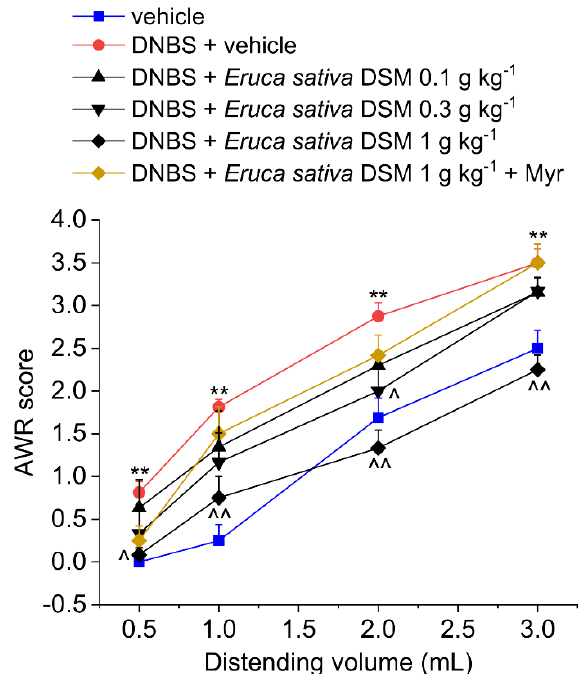
Figure 1. The effect of Eruca sativa DSM acute administration on post-inflammatory visceral pain caused by colitis in rats before and after bio-activation with myrosinase enzyme (Myr). Visceral sensitivity was assessed in animals by measuring the extent of the abdominal withdrawal response (AWR) to colorectal distension, carried out by applying an increasing distending stimulus on the colon walls (0.5–3 mL). The test was performed 30 min after the E. sativa DSM oral administration. Each value represents the mean ± SEM of six animals per group. ** p < 0.01 vs. vehicle. ^ p < 0.05 and ^^ p < 0.01 vs. DNBS + vehicle.